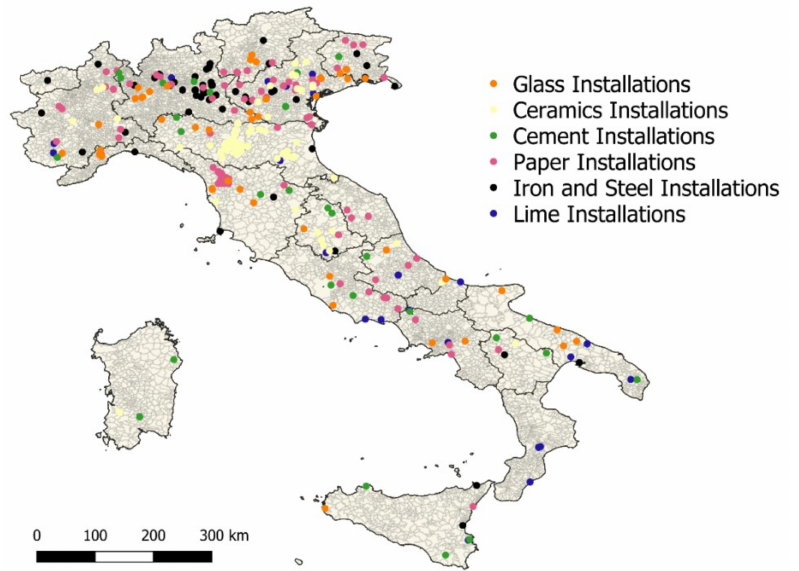
Figure 2. Map of industrial installations in Italy according to selected economic activity